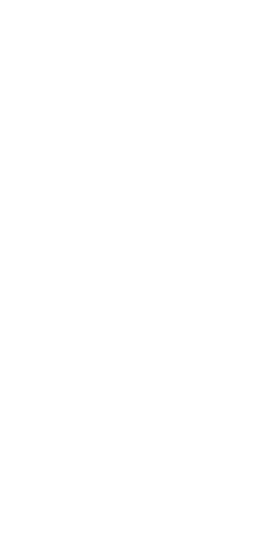
Table 6. Self-rated confidence and knowledge in advising patients about physical activity by professional group How would you rate your confidence in giving general advice to patients about physical